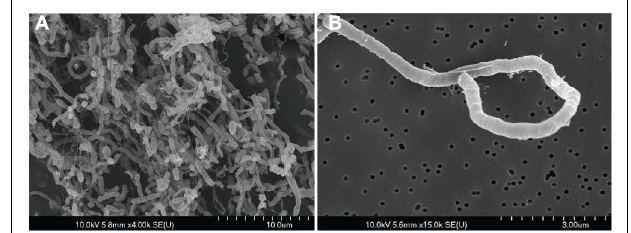
FIGURE 1 | (A,B) Scanning electron microscopy images of H. hydrogenoformans showing the long, curved nature of the isolate. Cells pictured here were grown on 15mM cellobiose in liquid culture under non-agitated conditions at 30˚C, and pH 11 with 7% (v/v) NaCl. Cells were fixed with 2.5% (v/v) anaerobic glutaraldehyde, subjected to ethanol dehydration, critical-point drying, and coated with palladium.